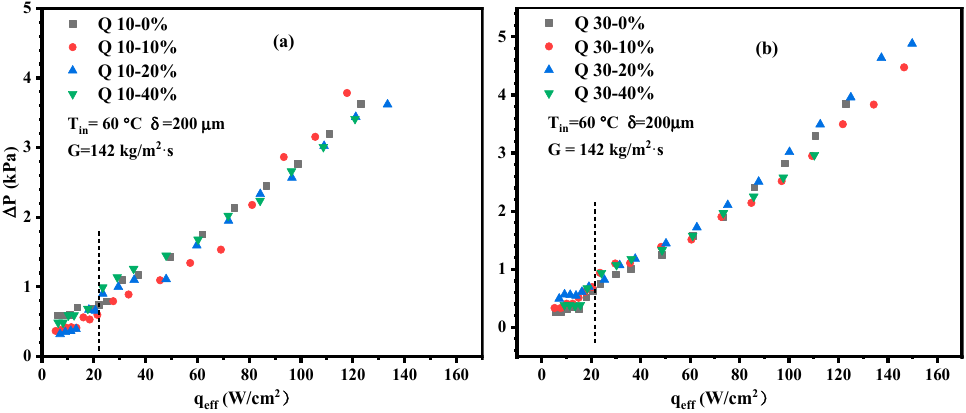
Figure 9. Average pressure drop curves of samples with different PFA contents. Dotted line represent boundary from single-phase to two-phase